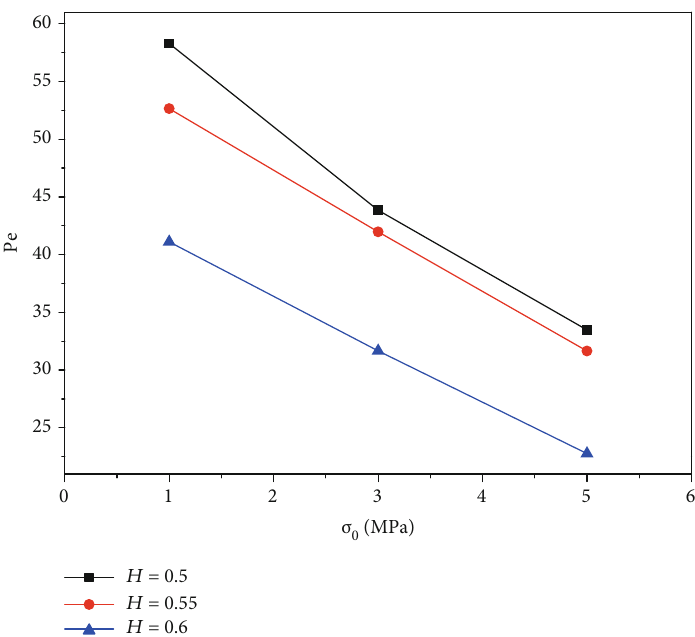
Figure 15: The Pe numbers when Q = 1 : 443 × 10 − 8 m 3 /s